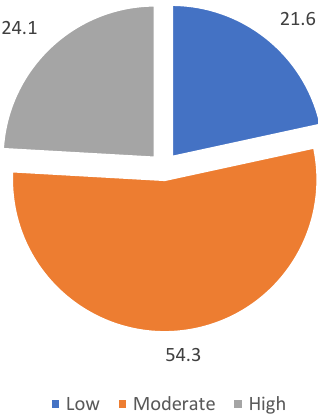
Figure 3. Level of farmers’ concern about climate change.